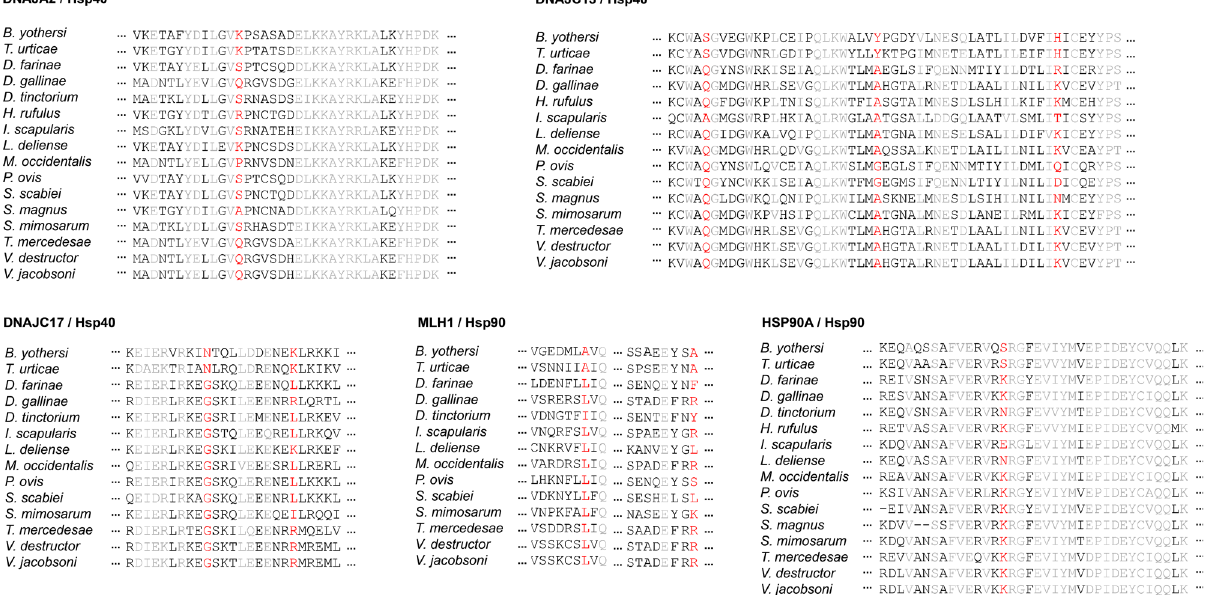
Fig. 4 The positively selected sites in HSP40 and HSP90 genes. Red indicates convergence